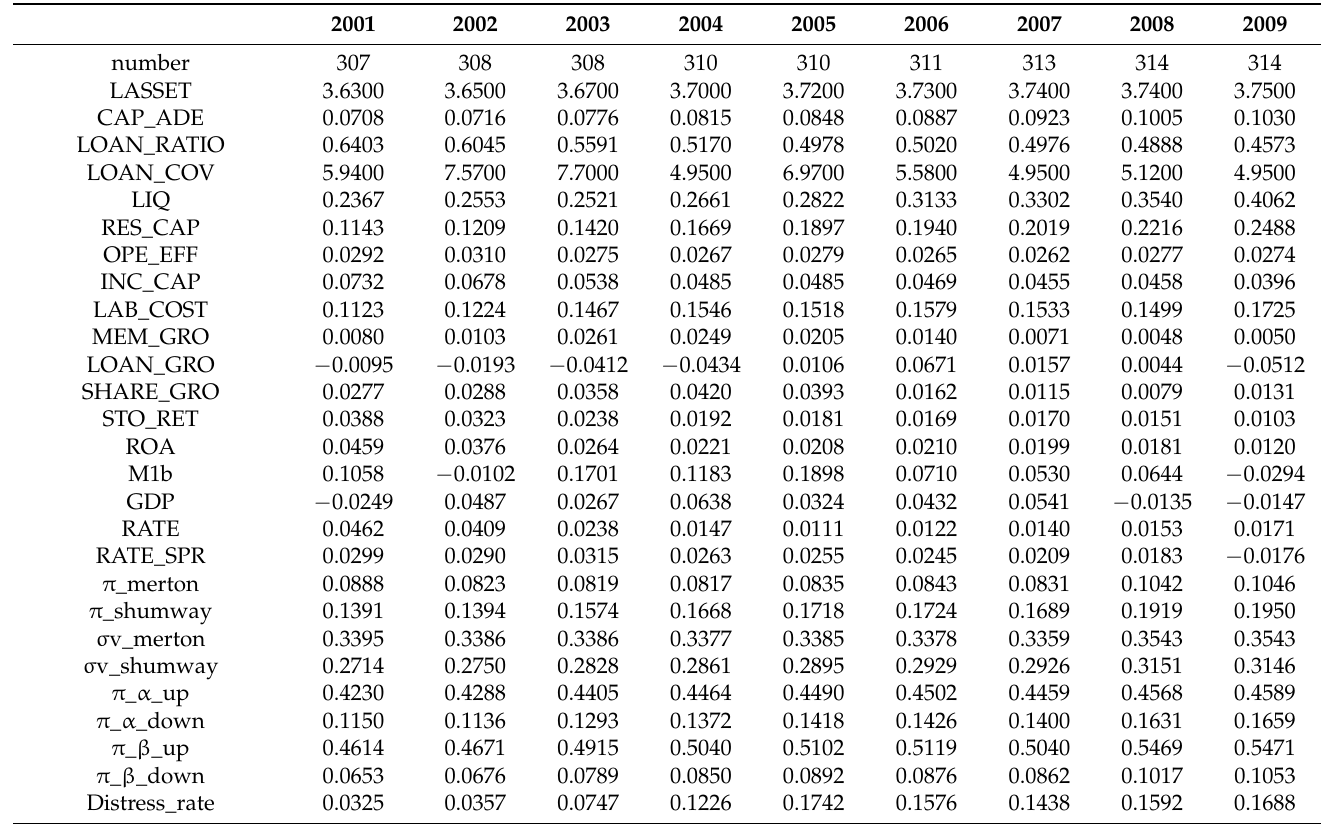
Table 4. Mean values of time-varying covariates by observation: All sample credit unions from